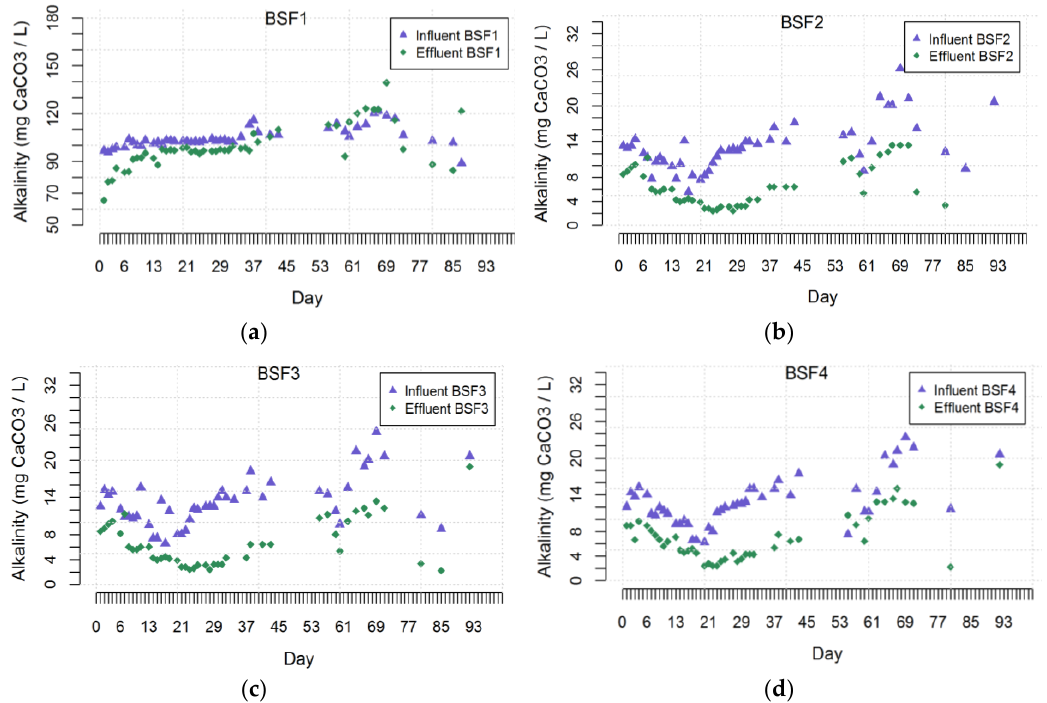
Figure 5. Comparison of alkalinity in influent vs. effluent over the course of the experiment: ( a ) BSF1, ( b ) BSF2, ( c ) BSF3, and ( d ) BSF4.